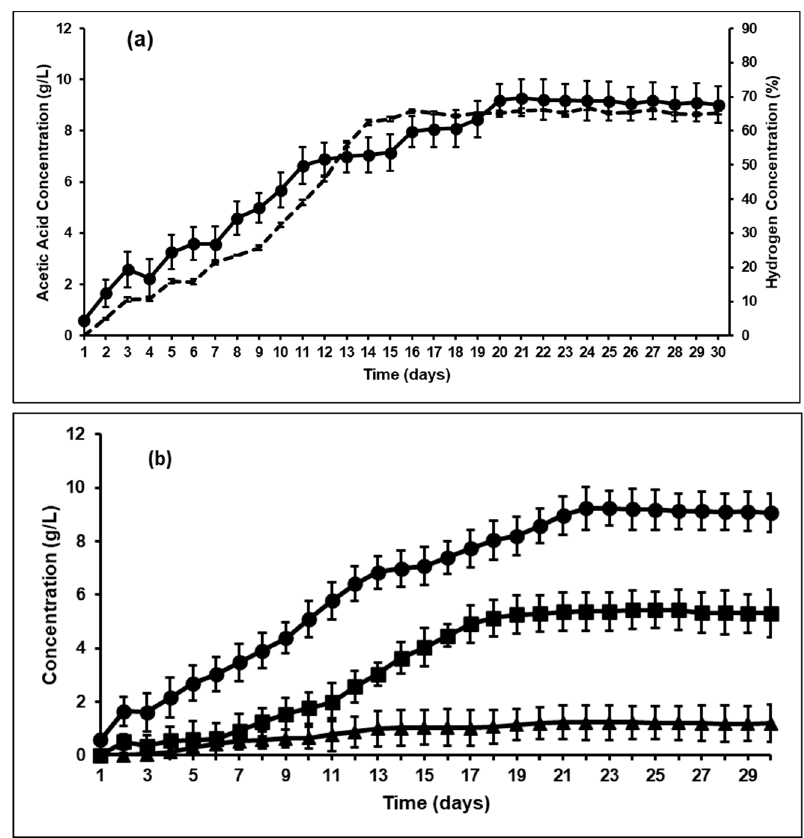
Figure 1. ( a ) Hydrogen concentration in headspace (wt%) versus acetic acid concentration (g/L); and ( b ) volatile fatty acids (VFA) profile; in control bioreactor after 2-bromoethanesulfonate (BES) addition and methanogenesis inhibition. ( — Hydrogen concentration (wt%); • Acetic acid concentration (g/L); Propionic acid concentration (g/L); Butyric acid concentration (g/L)). Table 2. Volatile fatty acids concentrations (g/L) in bioreactors with and without bioaugmentation and with 10 mM BES added. The bioreactors with and without methanogenesis were regarded as controls.